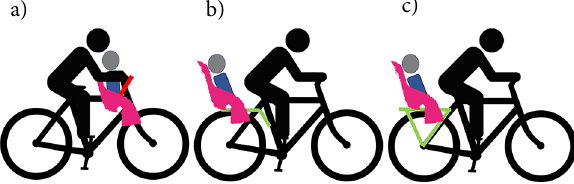
Figure 1. Child seat mounting configurations: a – front